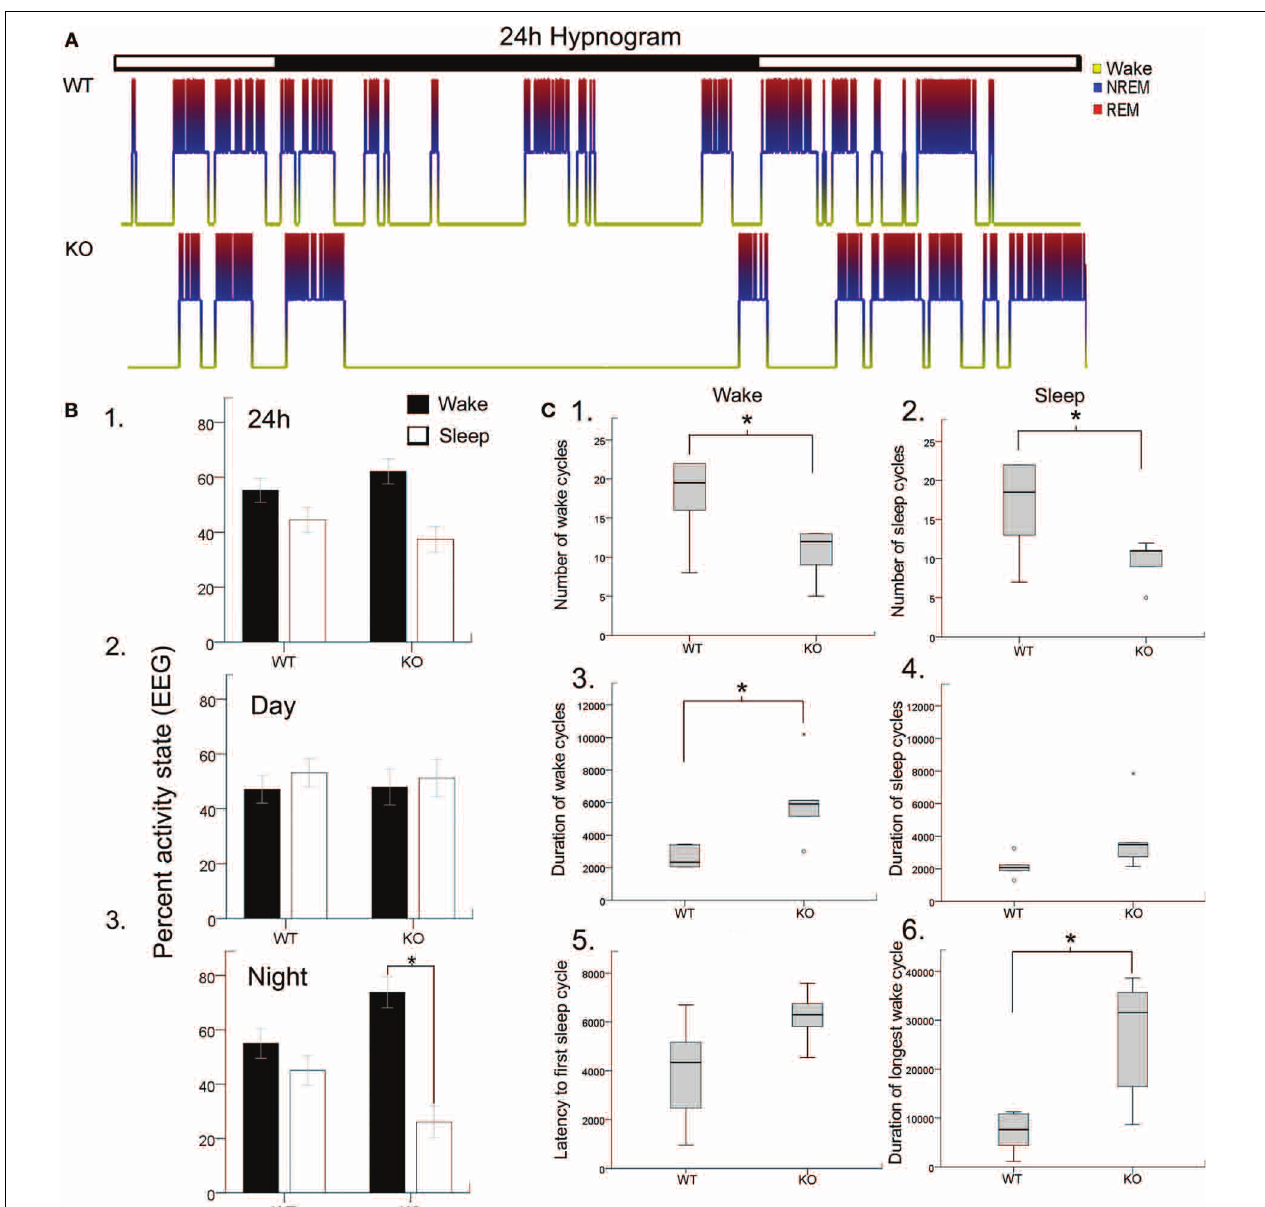
FIGURE 1 | Blinded video-EEG/EMG manual scoring quantitated activity cycles to generate (A). Hypnograms for each mouse in the study and showed significant sleep structure anomalies in the KO mice (B) . Histograms quantitating sleep/wake cycles for the data set (WT and KO n = 6 each) showed (B1) . No significant differences in percent time spent awake or sleeping were found when light/dark cycles (i.e., 24 h) were pooled together (lights on 7 am off 7 pm). However, when the data was split by light/dark cycle (B2,B3) . KO mice showed significant sleep deprivation compared to WT mice. The dark cycle longer wake periods were not associated with any significant